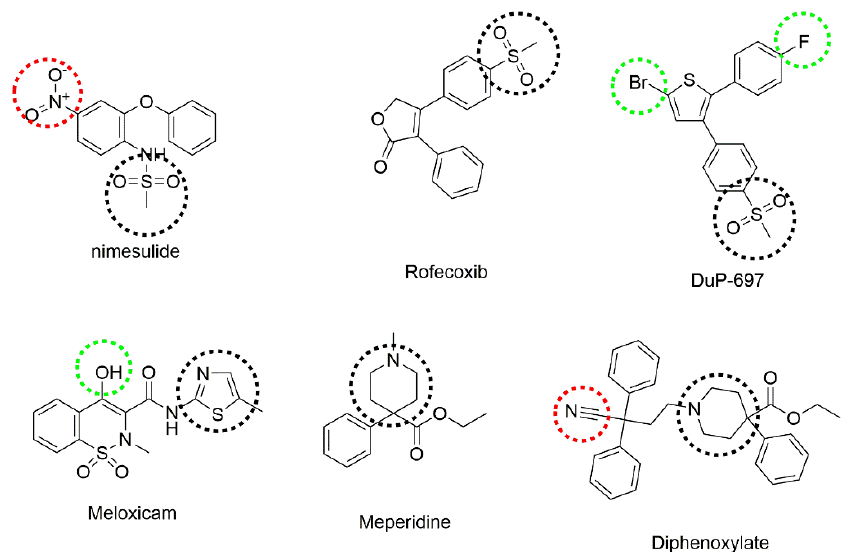
Figure 1. Some analgesic agents containing thiazole, secondary amine, or methylsulfonyl groups. Thiazole, secondary amine, or methylsulfonyl groups are marked in black, electron-donating sub- stituents are marked with green, and electron-withdrawing substituents are marked with red.